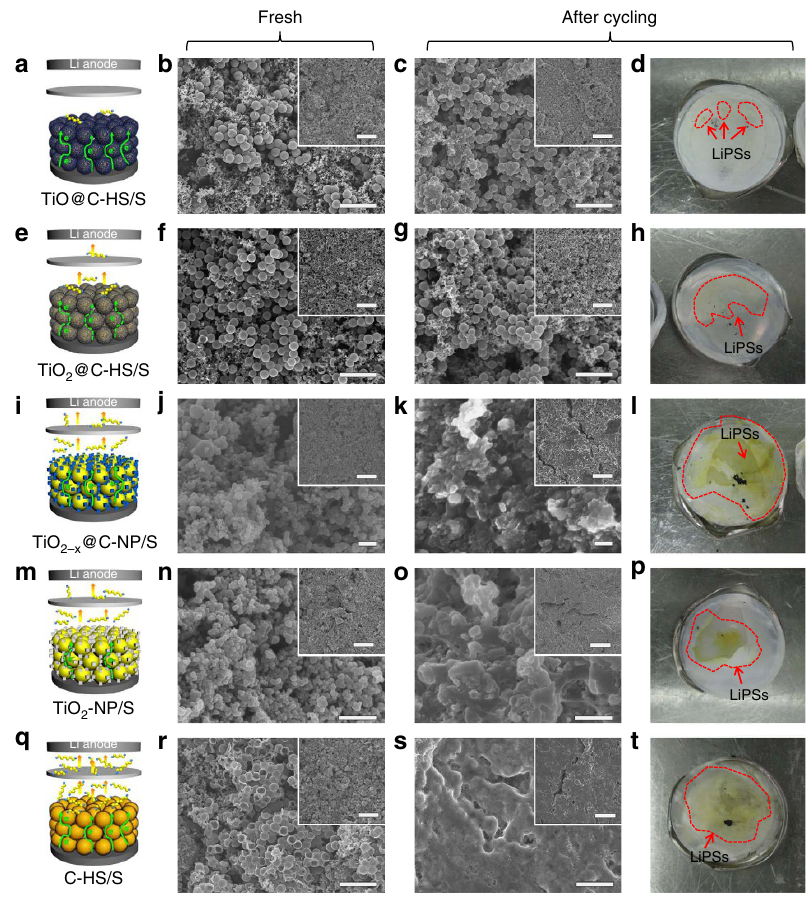
Figure 6 | Characterization of electrode films and separators during cycling. ( a , e , i , m , q ) Schematic illustration of the mechanisms during redox reaction, SEM images of ( b , f , j , n , r ) fresh electrode films, ( c , g , k , o , s ) cycled electrode films and ( d , h , l , p , t ) digital photos of cycled separators of ( a – d ) TiO@C-HS/S, ( e – h ) TiO 2 @C-HS/S, ( i – l ) TiO 2 (cid:2) x @C-NP/S, ( m – p ) TiO 2 -NP/S, and ( q – t ) C-HS/S. Scale bars, 2 m m ( b , c , f , g , r , s ), scale bars, 200nm ( j , k ), scale bars, 500nm ( n , o ), scale bars, 10 m m (insets of ( b , c , f , g , j , k , n , o , r , s